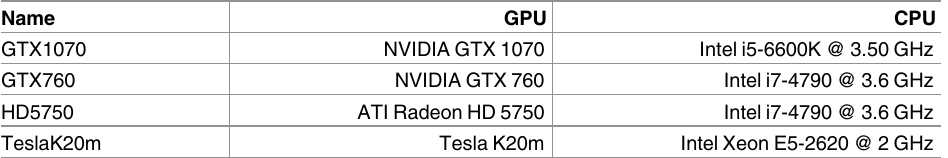
Table 3. The list of hardware configurations.